Question: Name the type of graph shown.
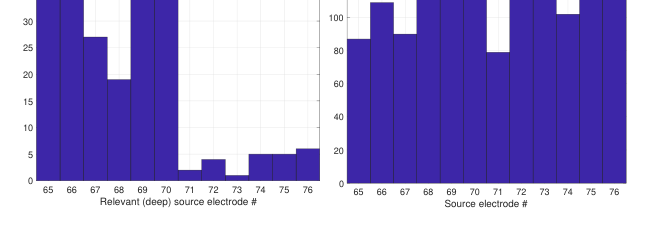
Answer: histogram